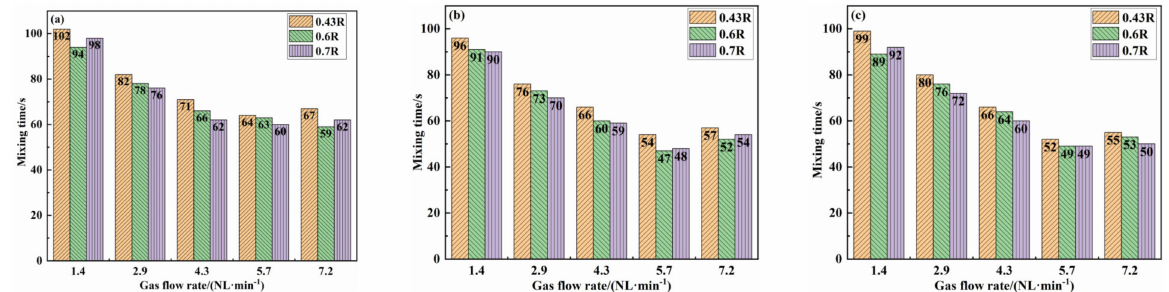
Figure 3. Effect of gas flow rate on MT at various radial angle: ( a ) 90 ◦ ; ( b ) 135 ◦ ; ( c ) 180 ◦